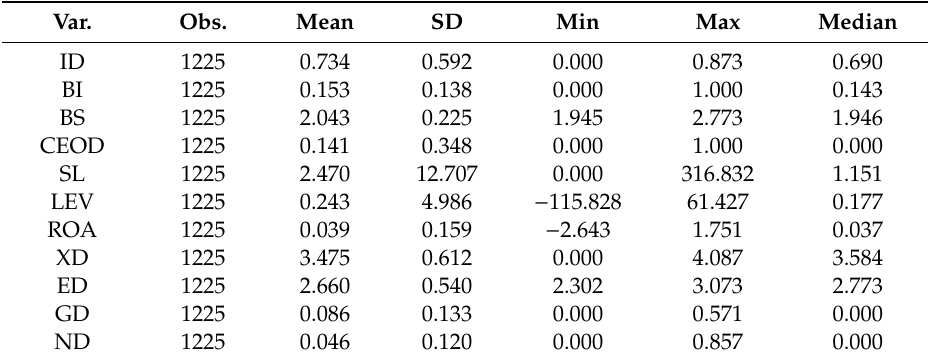
Table 3. Descriptive Statistics (Sample Size = 175, N = 1225). Panel